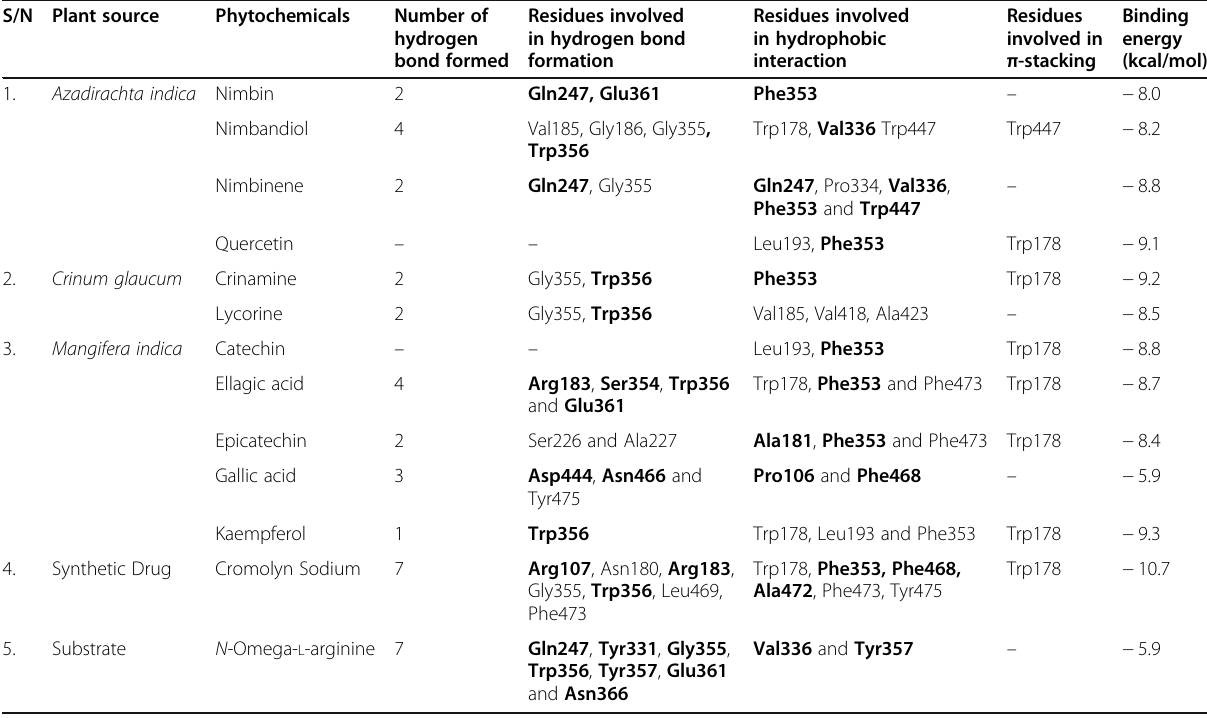
Table 3 Analysis of molecular interaction for the Phytochemicals with